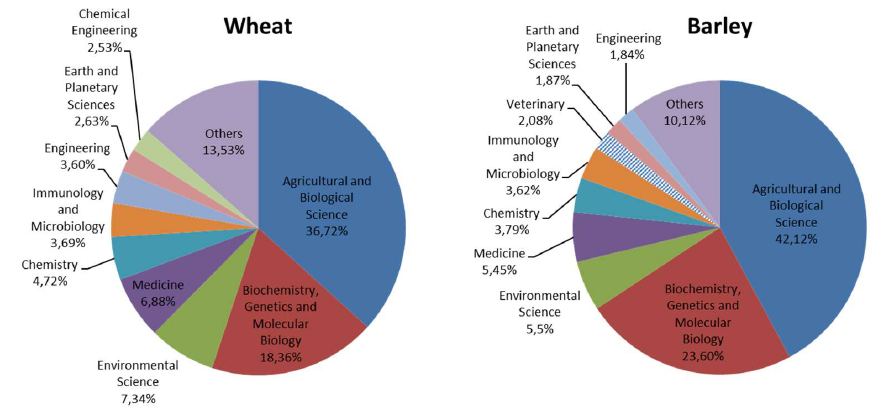
Figure 5. Distribution (%) of worldwide research on wheat and barley by subject area, as classified by Scopus.